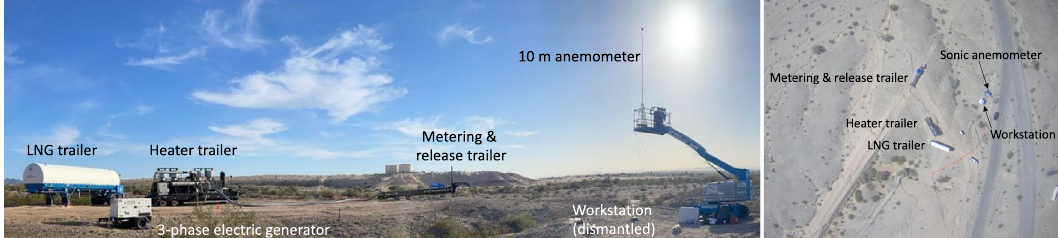
Figure 4. The experimental setup in panorama (left). Liquefied natural gas was reheated before flowing through a metering and release trailer. An aerial photograph of the site (right) [courtesy of Bridger Photonics